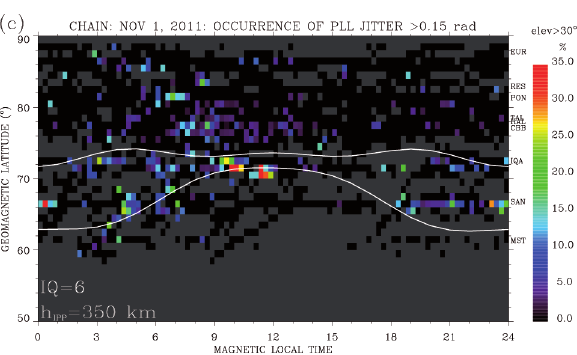
index (a), phase scintillation (b) and Figure 8. The occurrence of S 4 receiver PLL jitter (c) as functions of MLT and CGM latitude for November 1, 2011. The statistical auroral oval for very disturbed conditions is